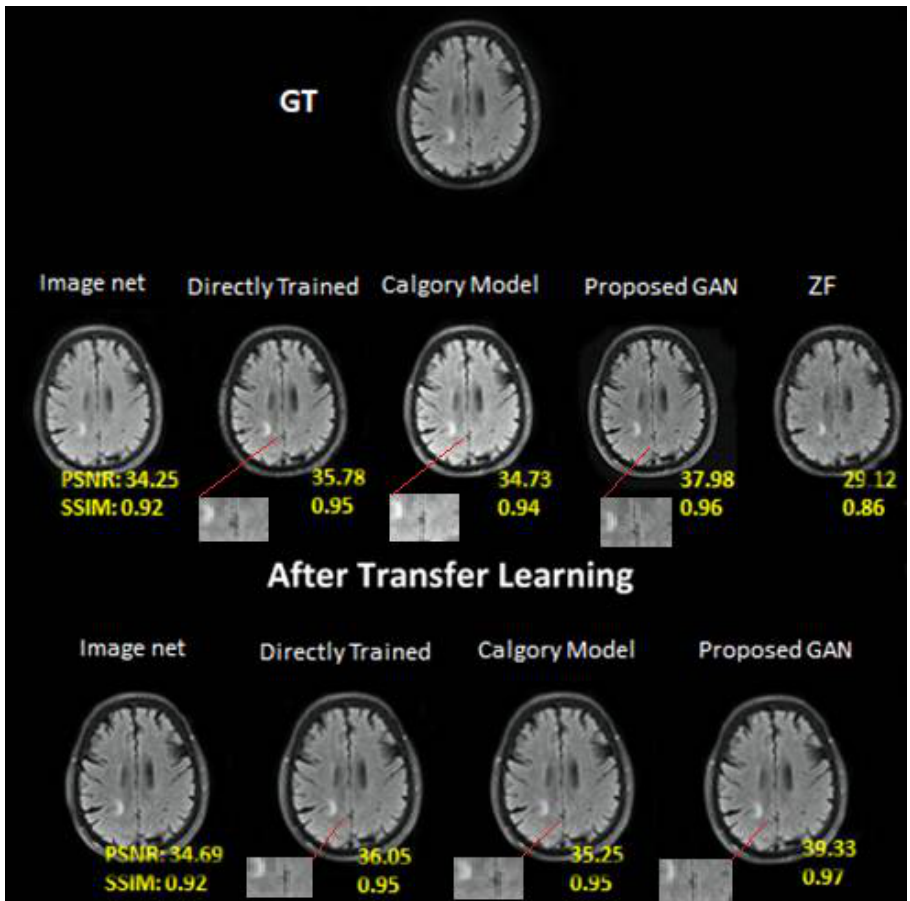
Figure 7. At AF = 2, Reconstruction results on private brain images. From left to right: (i) Image Net (IN); (ii) Directly trained (DT); (iii) Calgary Model (CM); (iv) Proposed GAN; (v) ZF. In the second row: (i) Image net; (ii) Directly Trained; (iii) Calgary Model; (iv) Proposed GAN results of same slices from brain image dataset after applying transfer learning.